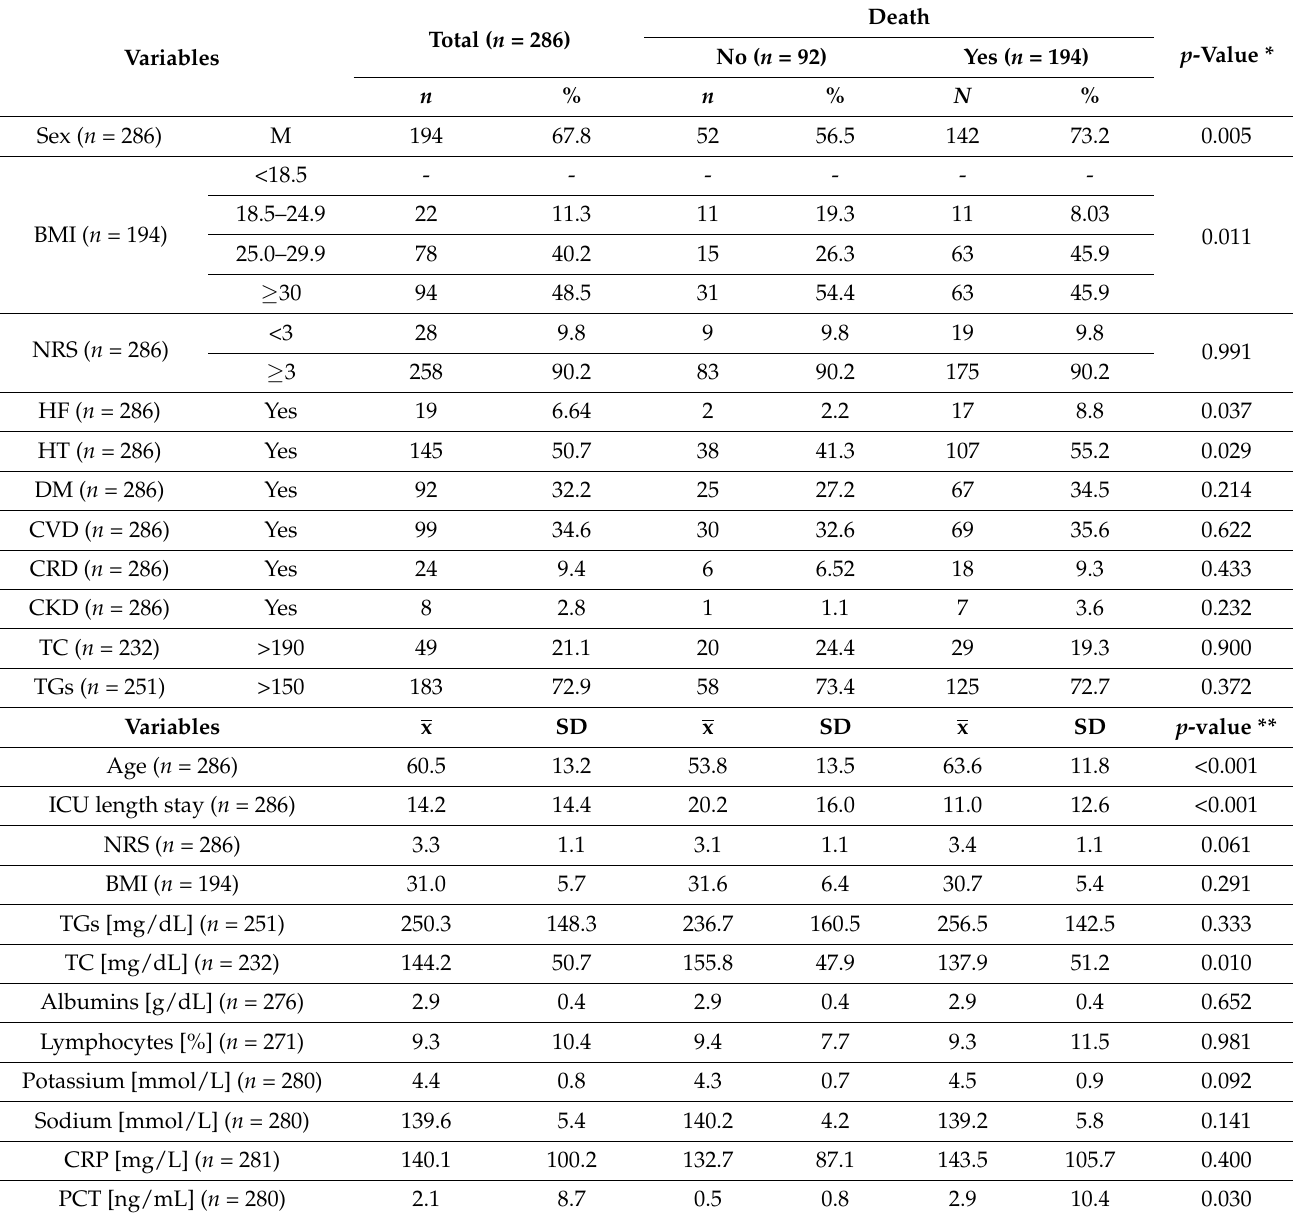
Table 1. Characteristics of the group with a comparison of survivors and